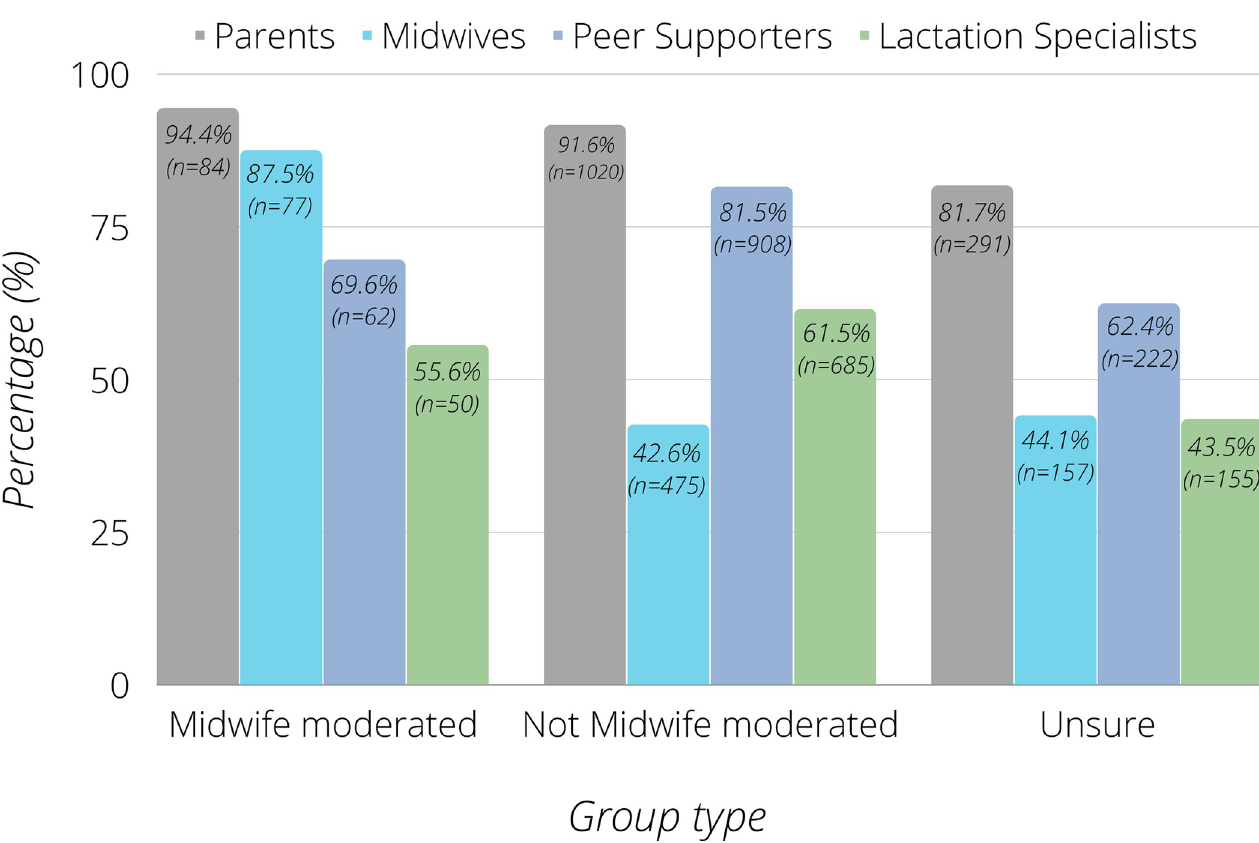
Fig 2. Participants who ‘often’/‘very often’ received support from different sources across different moderated Facebook group